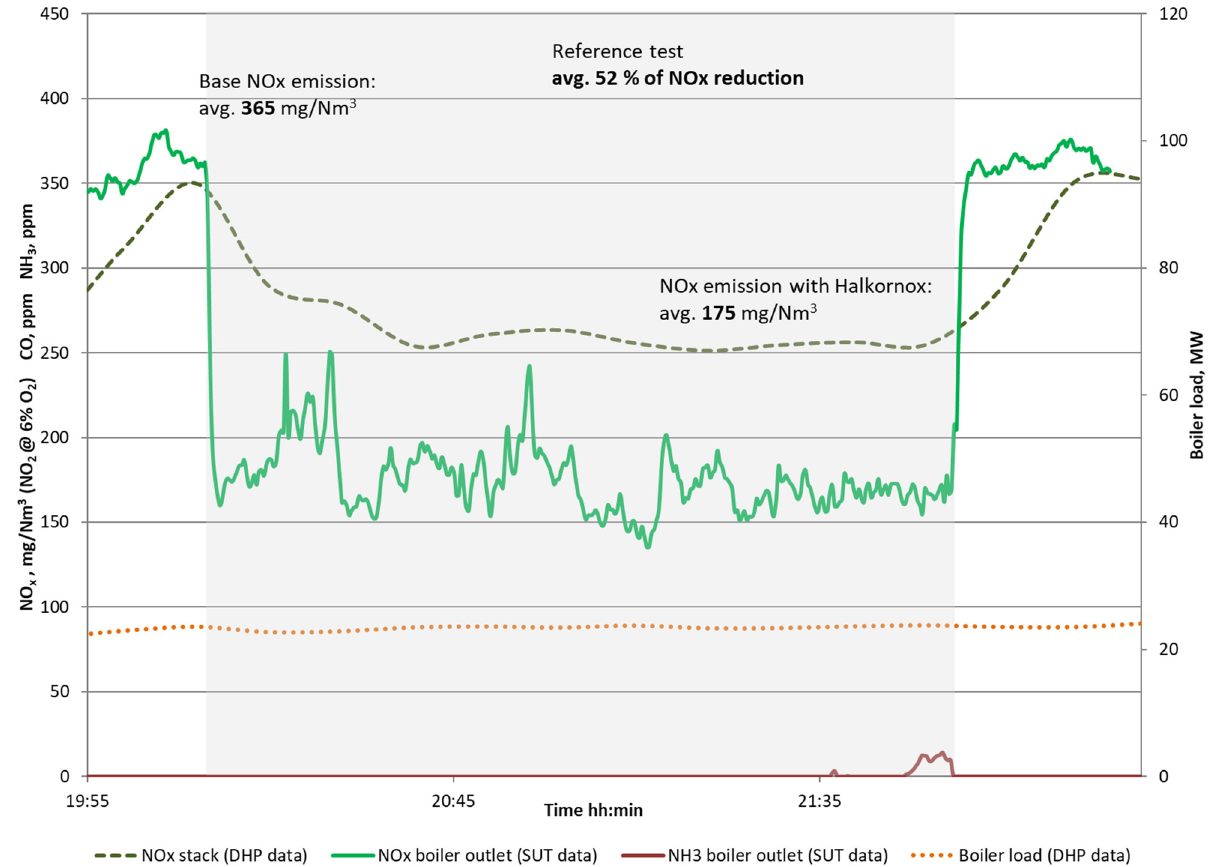
Figure 7. NO x and NH 3 emissions during HALKORNOKS reference tests measured by SUT and DHP equipment.